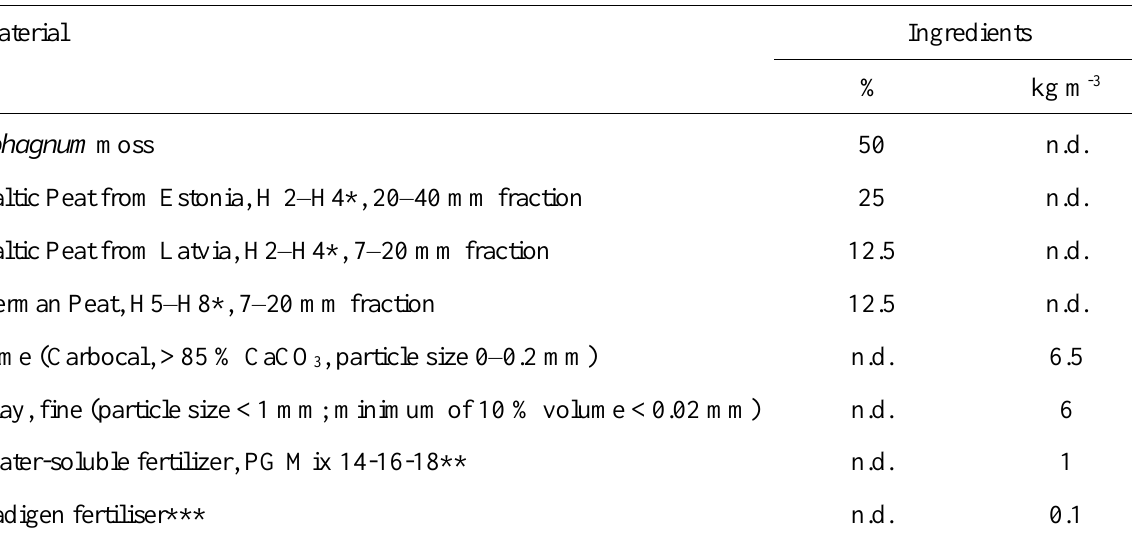
Table 1. Composition of the growing media mix.